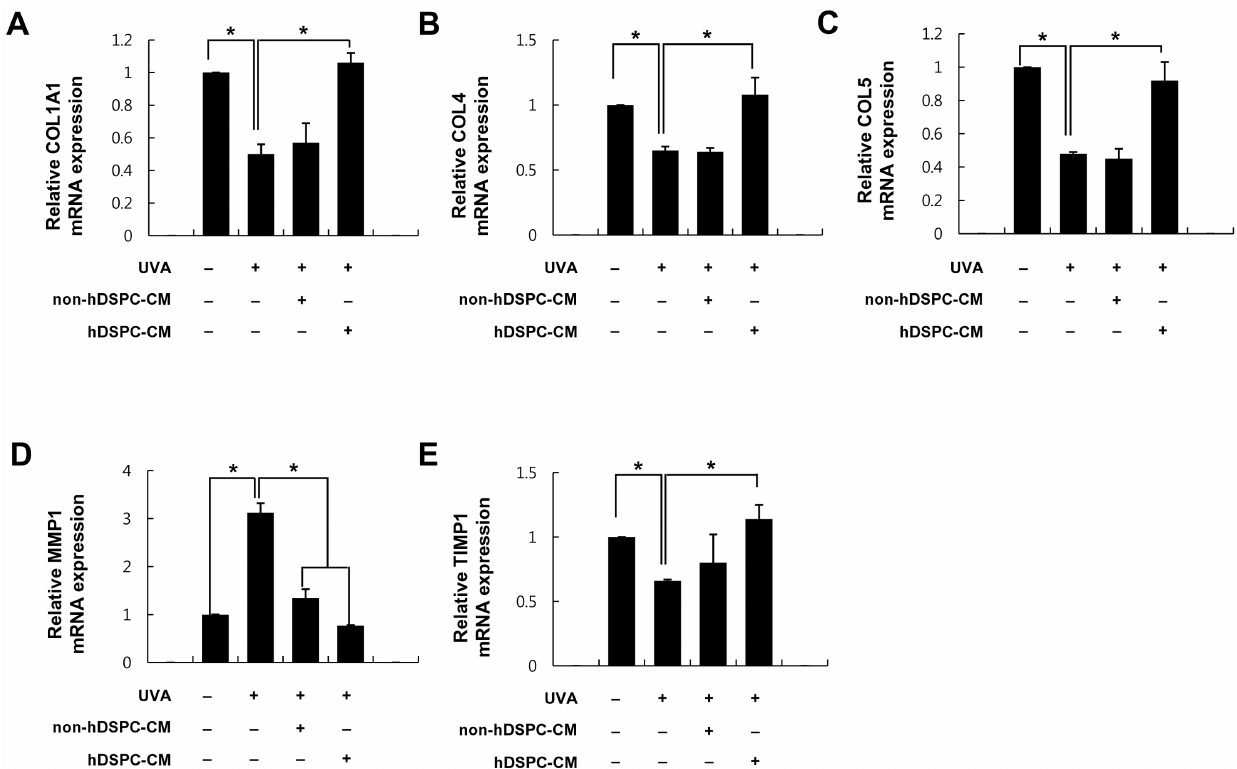
Figure 2. hDSPC-CM restored the down-regulated mRNA expressions of specific dermal makers in UVA-irradiated NHDFs. NHDFs were irradiated with UVA (6 J/cm 2 ) and treated with either hDSPC-CM or non-hDSPC-CM for 24 hr. Total RNA was extracted, and real-time RT-PCR was performed for COL1A1(A), COL4A1(B), COL5A1(C), MMP1(D), and TIMP1(E). The graphs are shown as the mean 6 S.D. of three independent experiments. * p ,